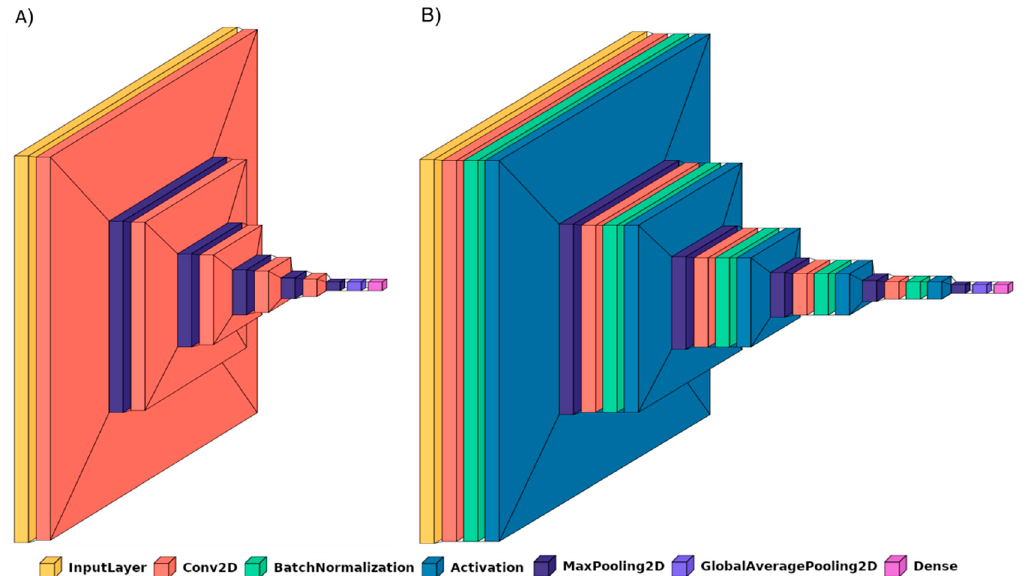
Figure 1. BrainNet2D network ( A ), and BrainNet2D network with Batch Normalization ( B ).